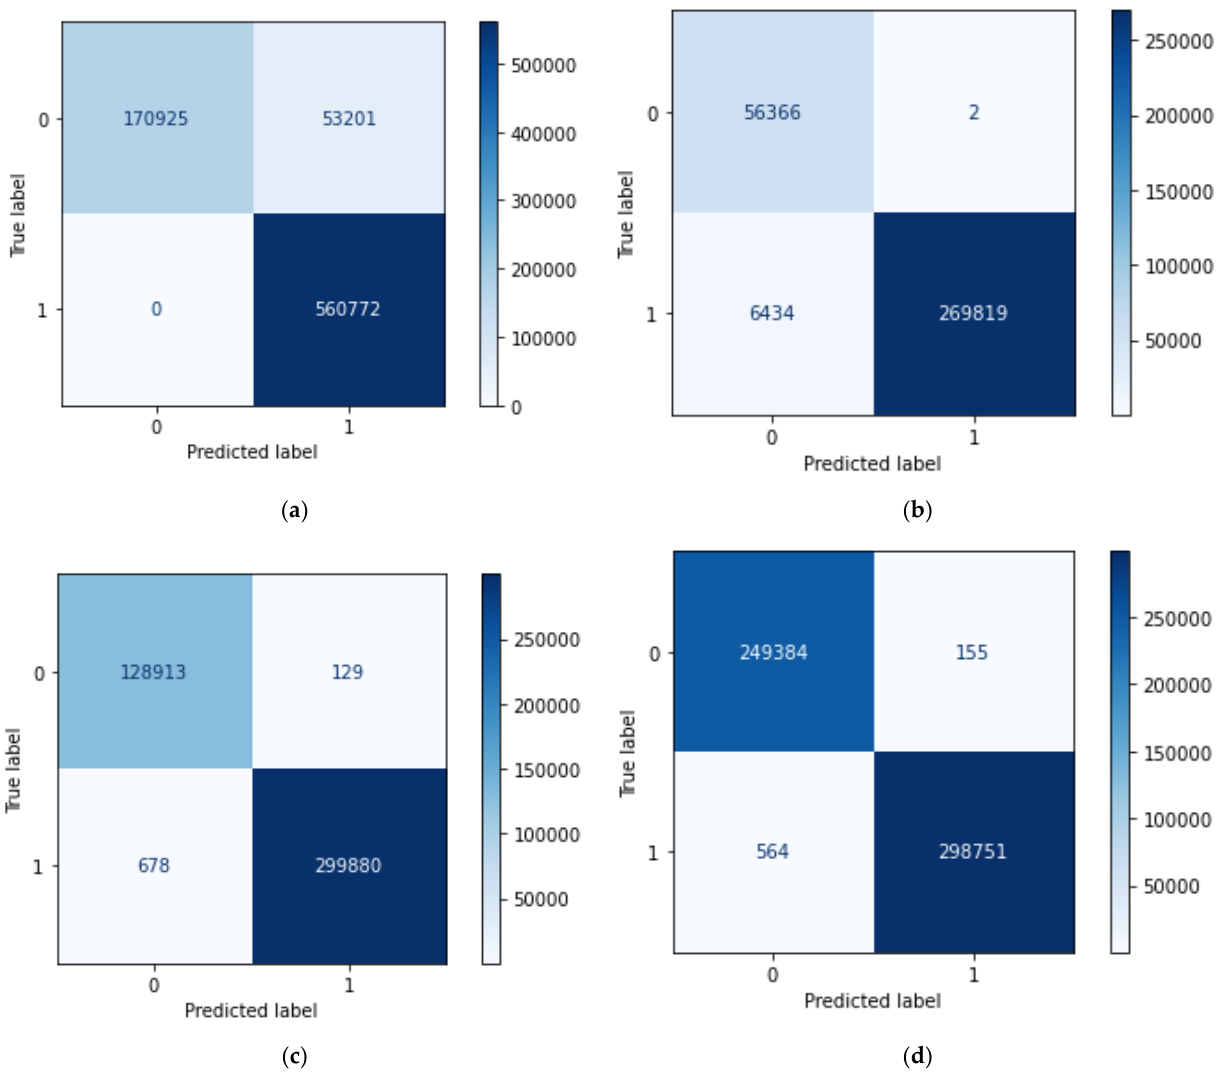
Figure 5. Confusion matrix for each experiment in Table 7. ( a ) Training with datasets 2 + 4 + 7 and test with dataset 9; ( b ) Training with datasets 2 + 4 + 9 and test with dataset 7; ( c ) Training with datasets 2 + 7 + 9 and test with dataset 4; and ( d ) Training with datasets 4 + 7 + 9 and test with dataset 2. Table 8. Results of random forests using three datasets as training data.